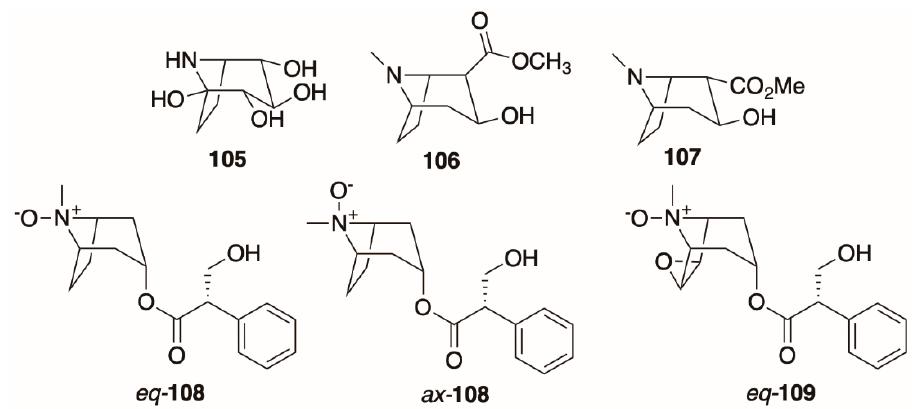
Figure 9. Calystegine, ecgonine alkaloids, and tropane N -oxides found in Datura species. Note that the “pseudo-” nomenclature for ecgonine alkaloids refers to the stereochemistry of the 2-carboxylate, not the 3-hydroxyl.